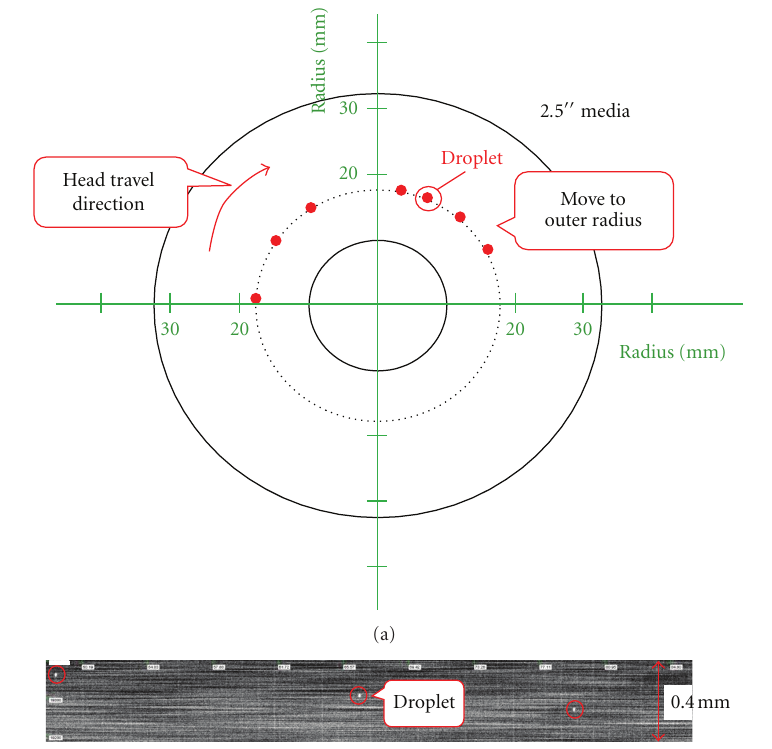
Figure 6: Droplet distribution map (a) and OSA image (b) on the media. The droplets in the down-track direction are located progressively further toward the disk outer radius, consistent with the head travel direction from inner to outer